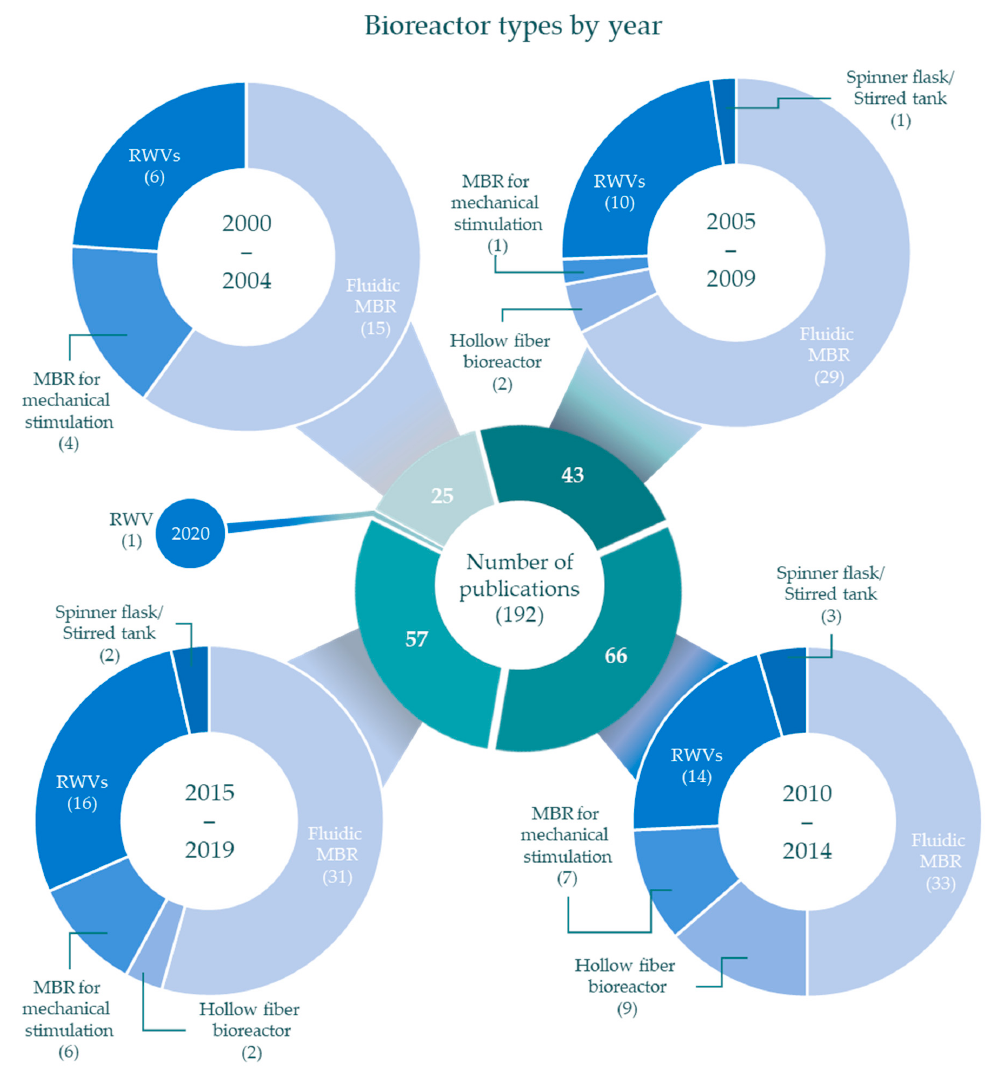
Figure 4. Distribution of micro-bioreactor types from 2000 to 2020 in the literature under